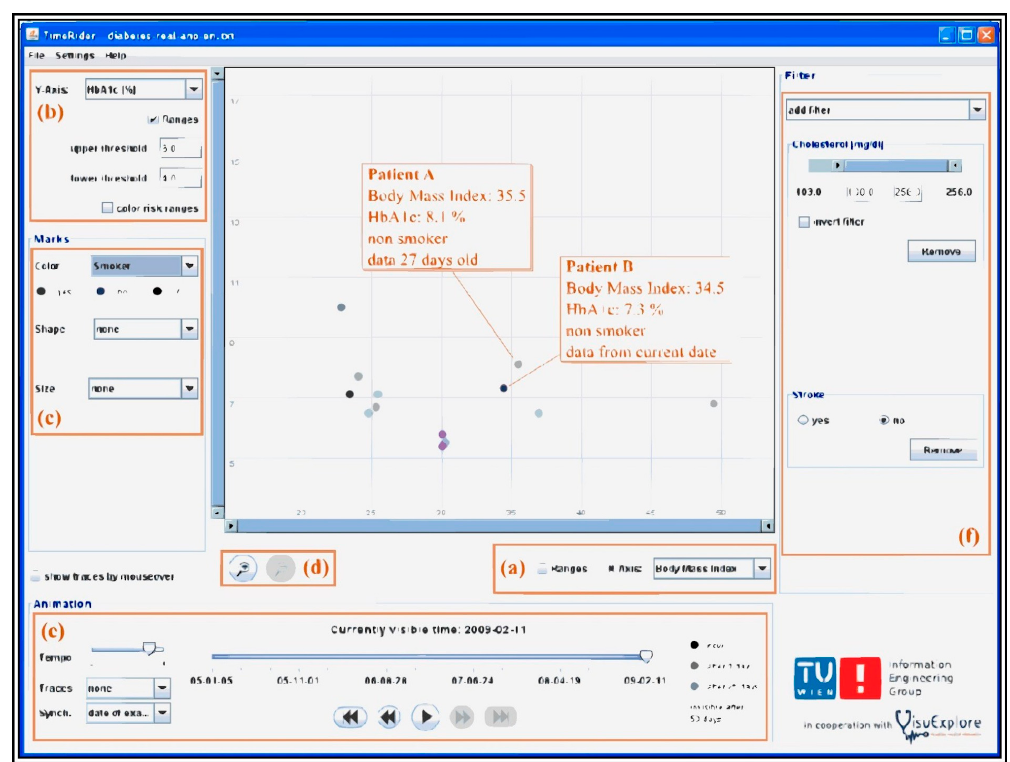
Figure 11. TimeRider: Interactive visualization tool for pattern recognition in patient cohort data. Source: reprinted by permission from Springer Nature: Springer, Ergonomics and Health Aspects of Work with Computers, Visually Exploring Multivariate Trends in Patient Cohorts Using Animated Scatter Plots , Rind A, Aigner W, Miksch S, et al., copyright